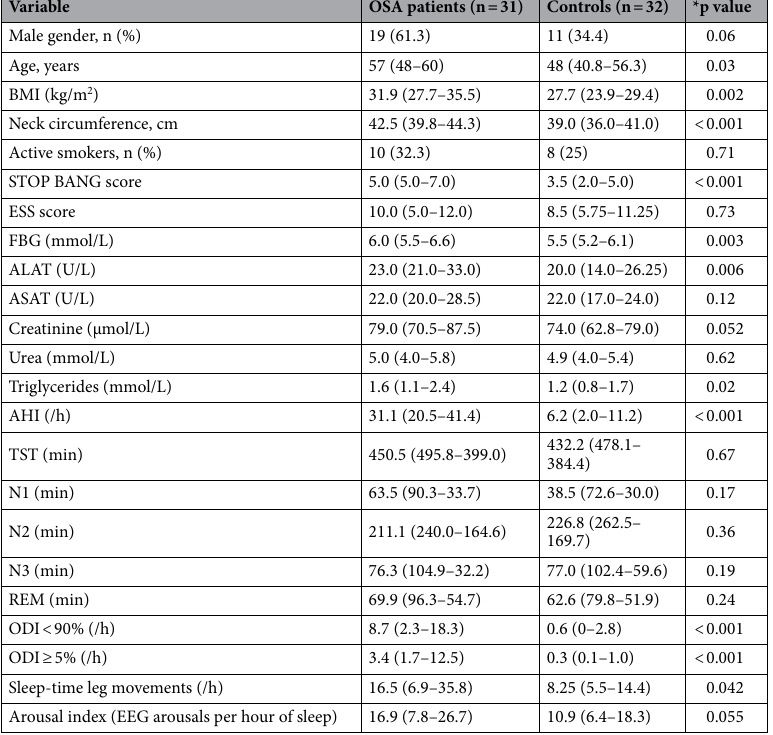
Table 1. Baseline characteristics of the study population, including serum biochemistry results (measured at 7:00 a.m.) and polysomnography data. Data are presented as median (IQR), unless otherwise specified. AHI apnea–hypopnea index, ALAT alanine aminotransferase, ASAT aspartate aminotransferase, BMI body mass index, EEG electroencephalography, ESS Epworth sleepiness scale, FBG fasting blood glucose, IQR interquartile range, N1–N3 time spent in N1, N2, and N3 sleep phases, respectively, ODI ≥ 5% amount of oxygen desaturations of at least 5% per hour of sleep, ODI < 90% amount of oxygen desaturations below 90% per hour of sleep, OSA obstructive sleep apnea, REM time spent in rapid eye movement (REM) sleep (sleep phases were scored according to the American Academy of Sleep Medicine guidelines 15 ), TST total sleep